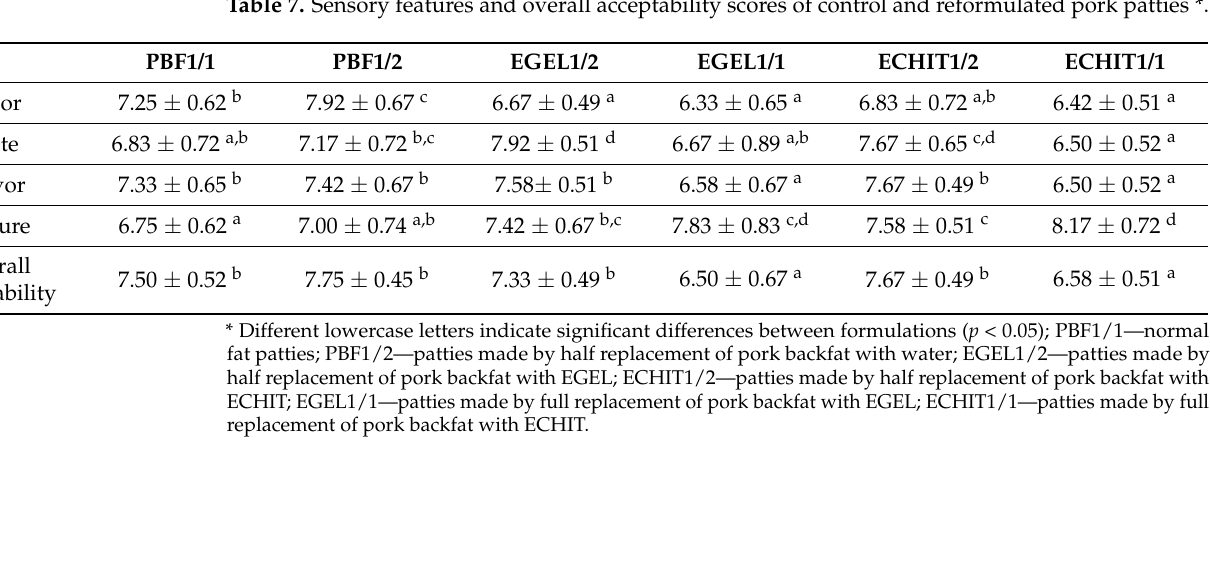
Table 7. Sensory features and overall acceptability scores of control and reformulated pork patties